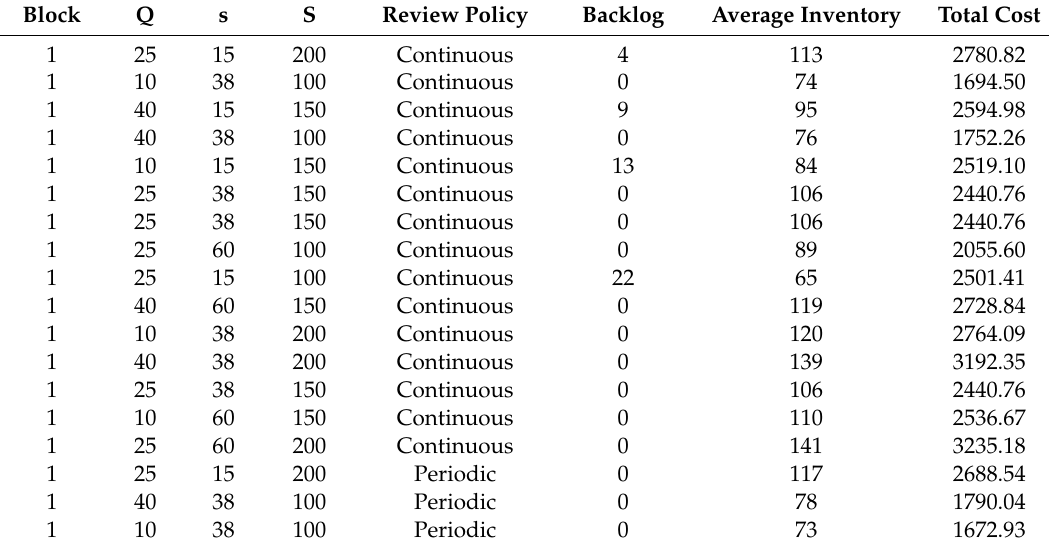
Table A3. Data set for running Box–Behnken design with 21